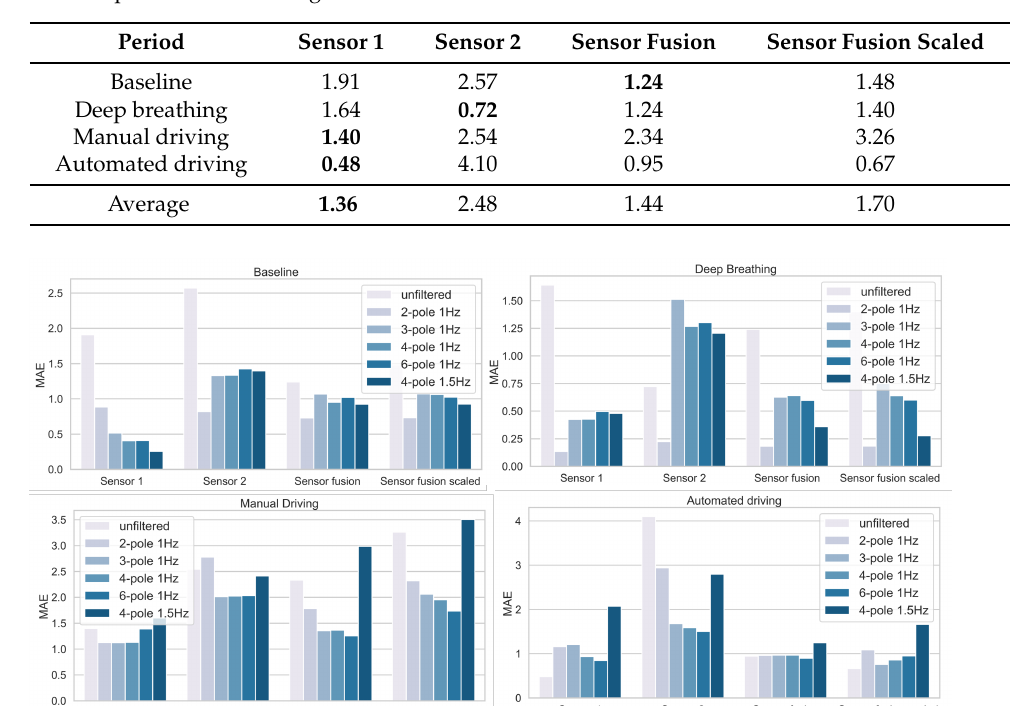
Table 5. Mean absolute error of respiratory rate (in min − 1 ) measured from data collected in the third test session for each sensor and period. Values in bold are the lowest errors achieved by the system for each period and in average.